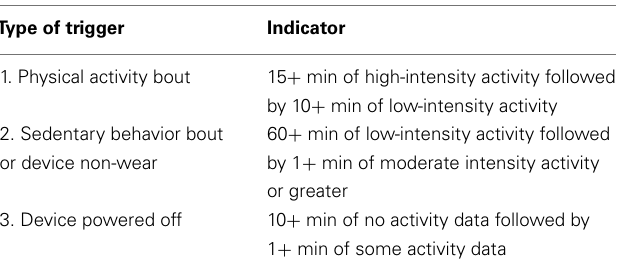
Table 1 | Sensor-informed context-sensitive ecological momentary assessment (CS-EMA) triggering